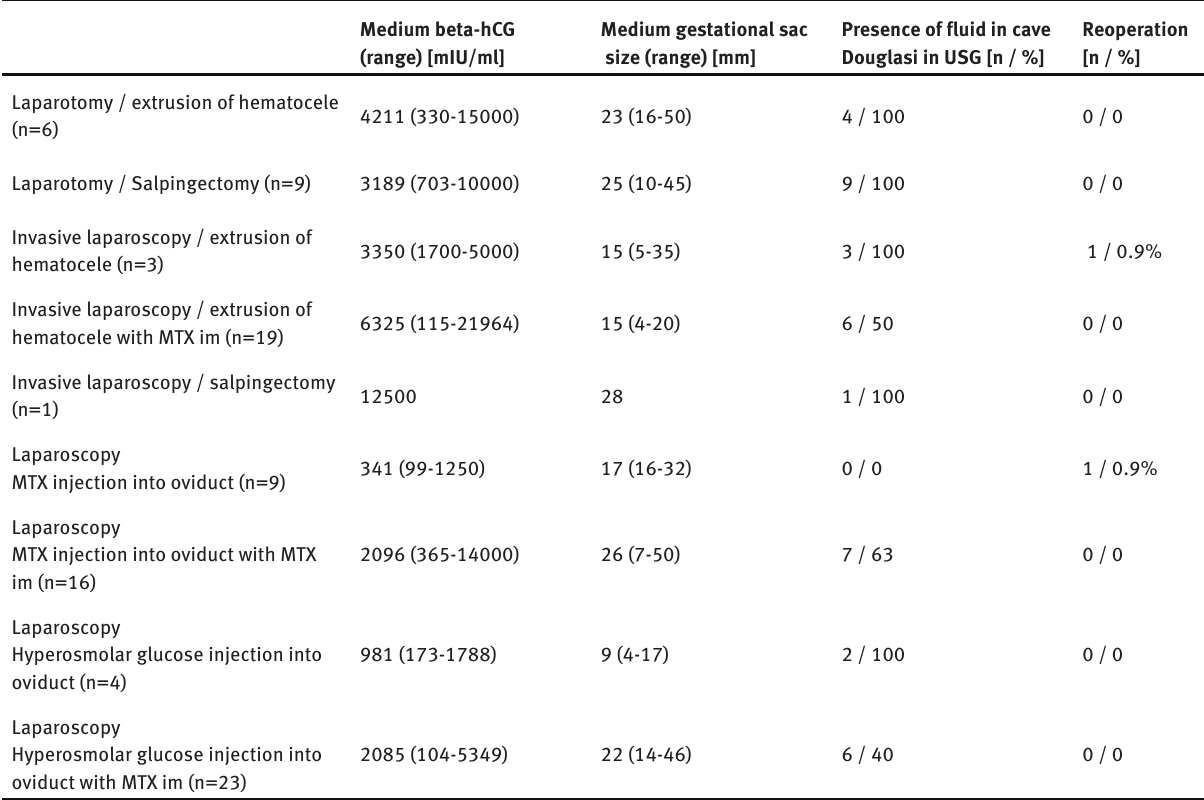
Table 3: (n=91) Beta-hCG level, gestational sac size, intraabdominal bleeding and reoperation necessity depends on treatment.